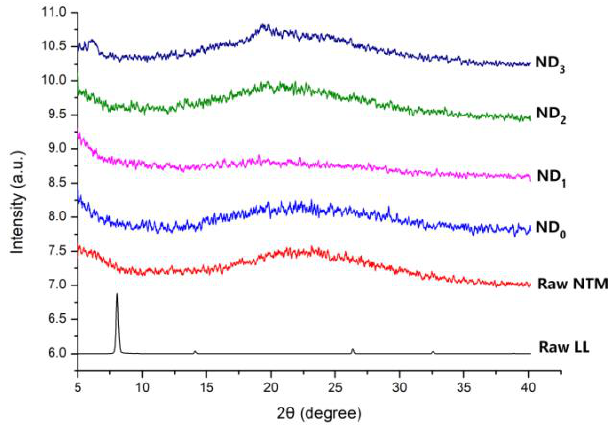
Figure 5. Powder X-ray diffraction (PXRD) patterns of raw NTM, raw L-leucine (LL), and NTM DPIs.